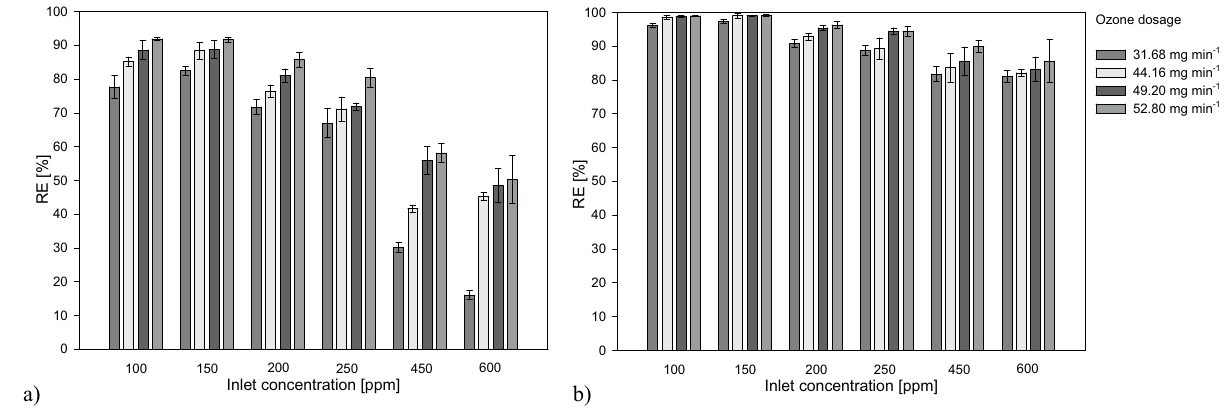
Figure 1. Influence of toluene inlet concentration on the Removal Efficiency (RE) under different ozone dosage applying the UV/O 3 system ( a ) and the UV/O 3 + S system ( b